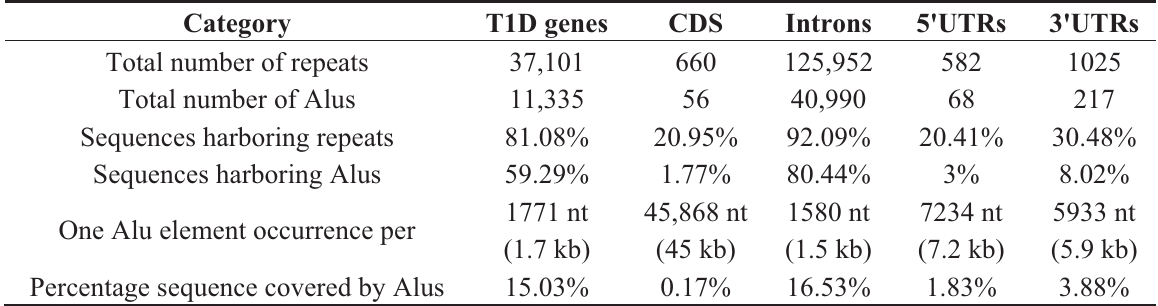
Table 2. Distribution of Alu repeats in T1D genes. The distribution of Alu repeats